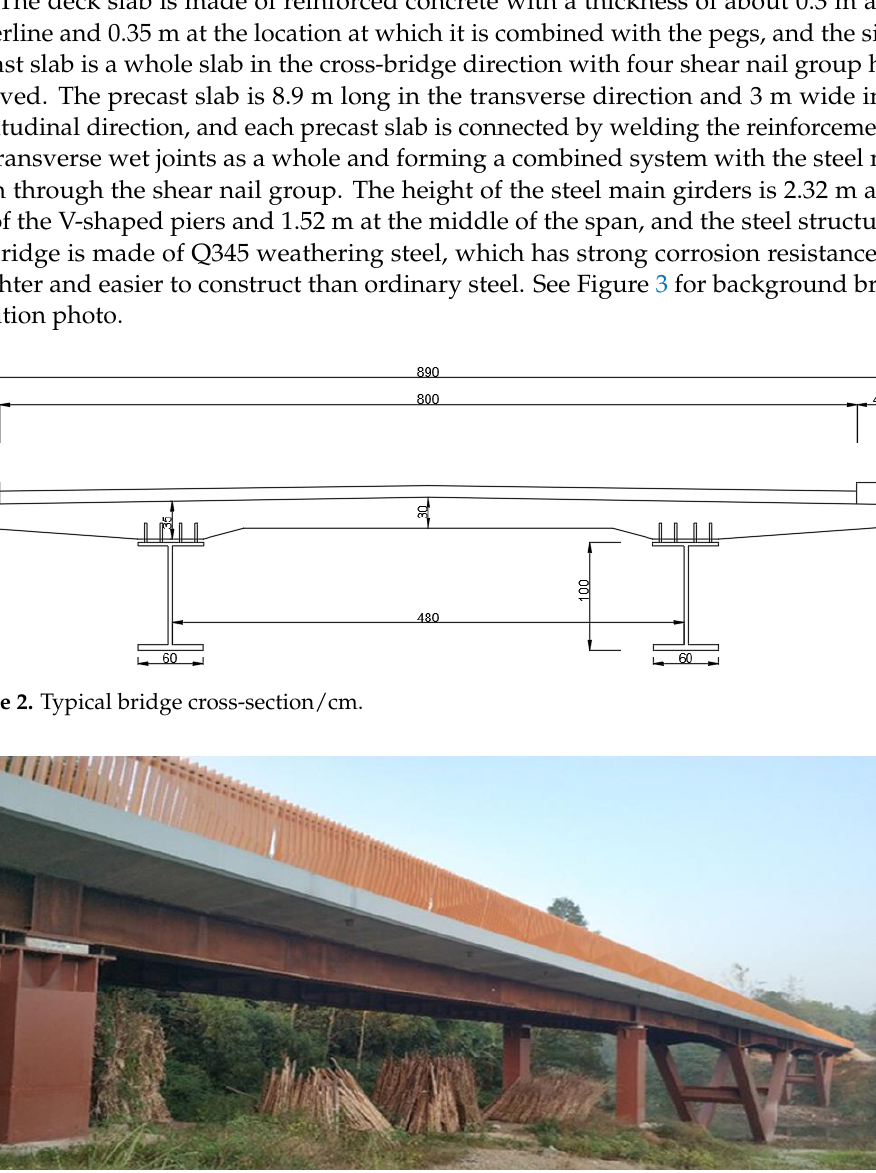
Figure 1. Elevation layout of the bridge/m.